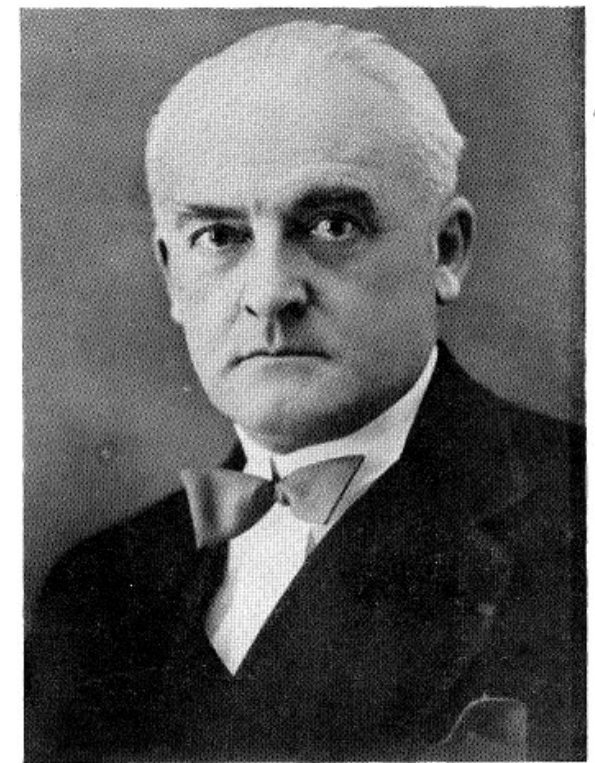
Figure 1. Portrait of Dr. Jacques Liouville (1879–1960), first direc- tor of the “Institut Scientifique Chérifien” (from his biography by R. Ph. Dollfus published in the Bulletin de la Société des Sciences naturelles et physiques du Maroc, Tome 40, 4ème trimestre